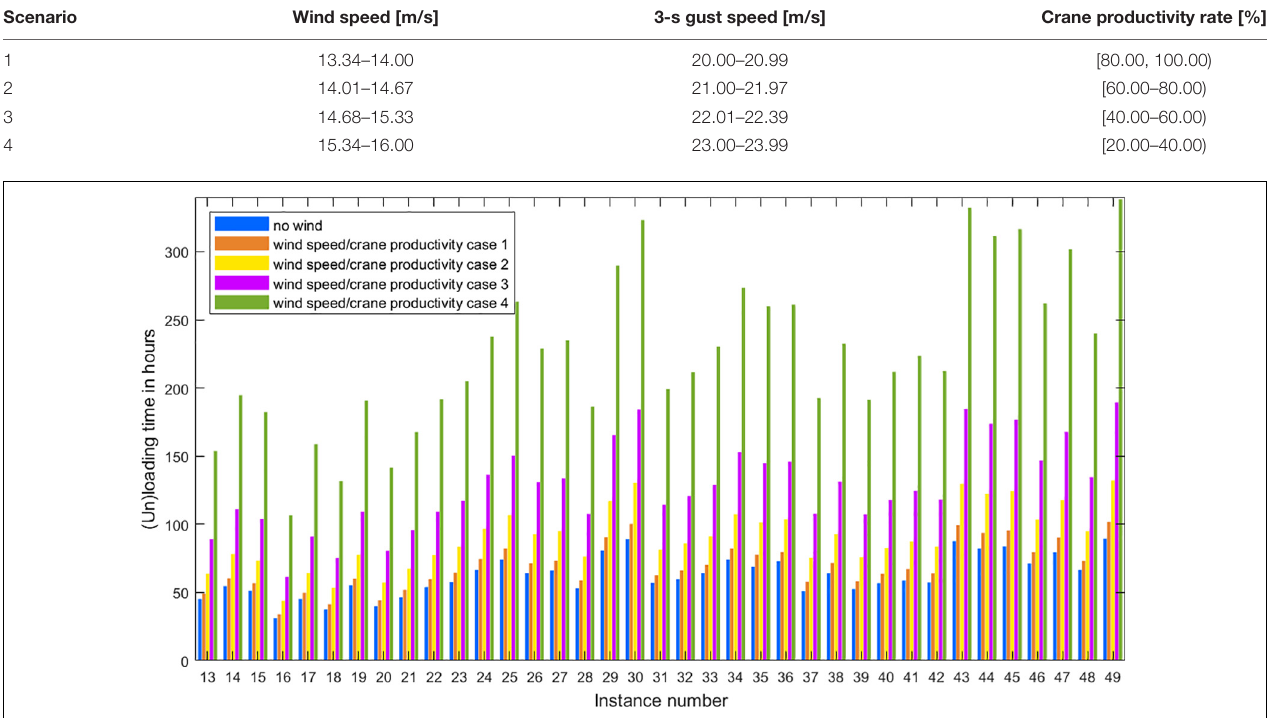
FIGURE 8 | Time for the entire (un)loading process per ocean-going vessel in hours under the considered wind speed/crane productivity